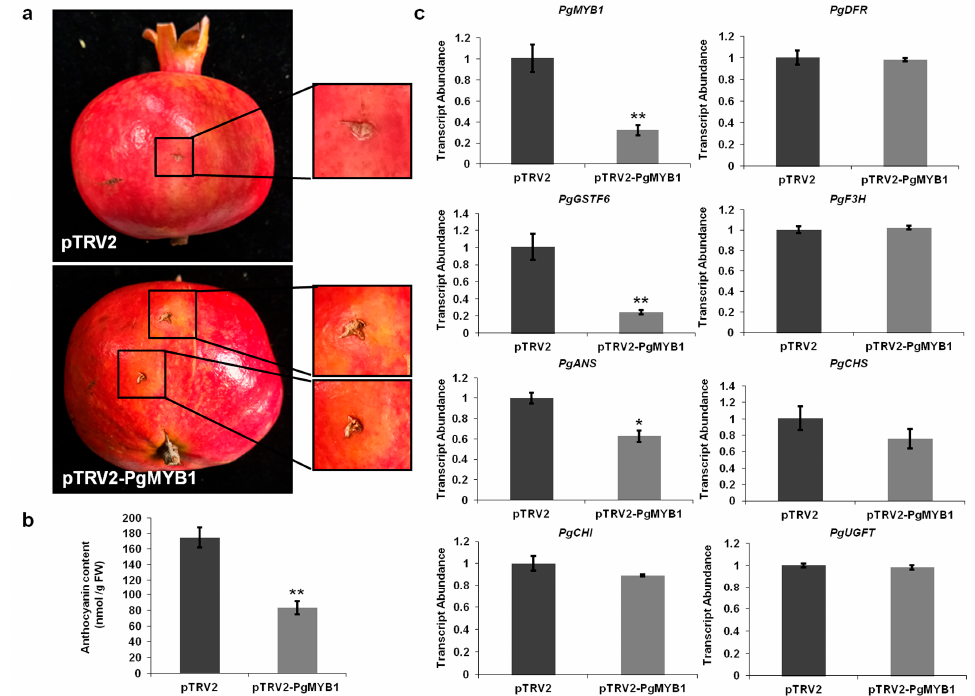
Figure 4. PgMYB1 positively regulates anthocyanin accumulation in pomegranate. ( a ) The phenotypes of TSH fruits after PgMYB1 silencing. The pTRV2 empty vector was used as the control. ( b ) The anthocyanin contents in fruit peels of TSH fruits after PgMYB1 silencing. ** p -values < 0.01 were considered statistically significant. ( c ) Transcription levels of PgMYB1 , PgGSTF6 , and the genes in the anthocyanin pathway in TSH fruits after PgMYB1 silencing and the pTRV2 empty vector control. Chalconesynthase (CHS accession number: AHZ97870.1), chalcone isomerase (CHI accession number: AHZ97871.1), flavanone 3-hydroxylase (F3H accession number: AHZ97872.1), dihydroflavonol 4-reductase (DFR accession number: AHZ97873.1), anthocyanidin synthase (ANS accession number: AHZ97874.1), and UDP-glucose: flavonoid-3-O-glucosyltransferase (UFGT accession number: AHZ97875.1). qRT-PCR was conducted in three biological replicates and three technical replicates, and one representative biological repeat is shown. * p -values < 0.05, ** p -values < 0.01 were considered statistically significant.